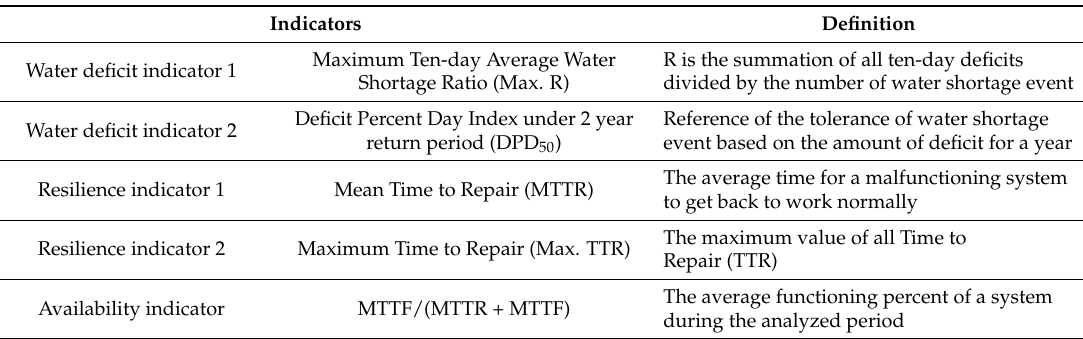
Table 1. Definition of the